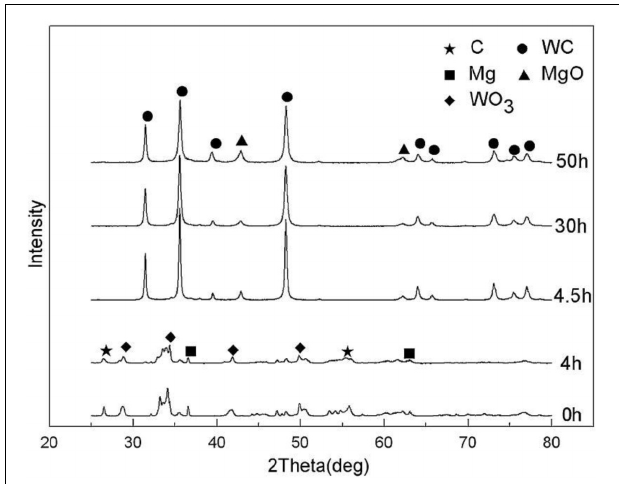
FIGURE 9 | XRD patterns of composite powders at different ball milling time (Wu et al., 2009) [Figure 1 of Wu et al. (2009), Copyright Elsevier B.V.].